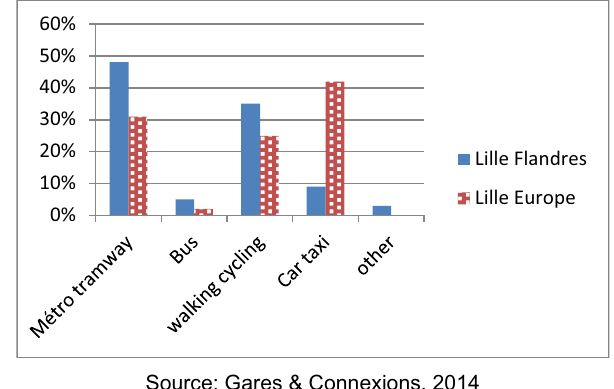
Fig. 5 Modal share of both B Gare Lille Flandres ^ and B Gare Lille Europe ^ railway stations. Source: Gares & Connexions